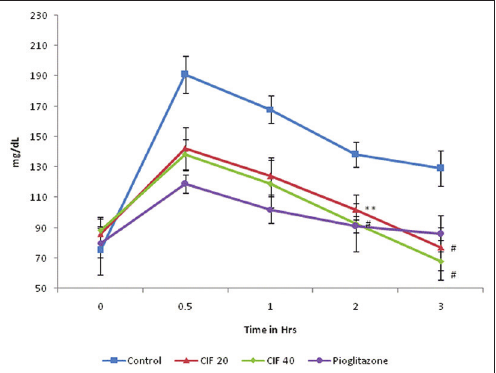
FIGURE 1. Effect of CIF on glucose overloaded hyperglycemia in normal rats (n=6). Blood glucose levels of CIF 20, 40 and piogl‑ itazone treatments were compared with that of control group at respective time intervals ** p<0.01. # p<0.001.